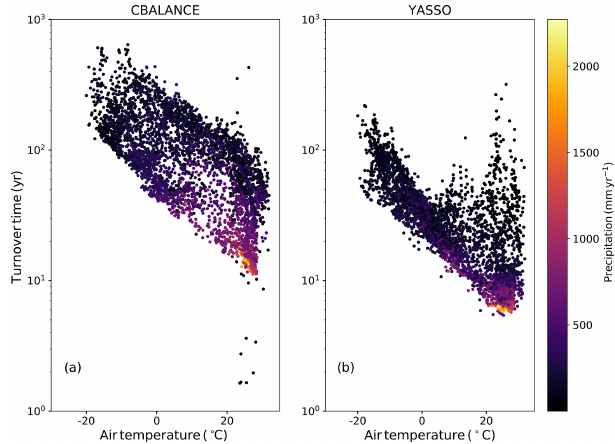
Figure 4. The turnover times for different temperature and precipi- tation regimes for the CBALANCE (a) and Yasso (b) models.